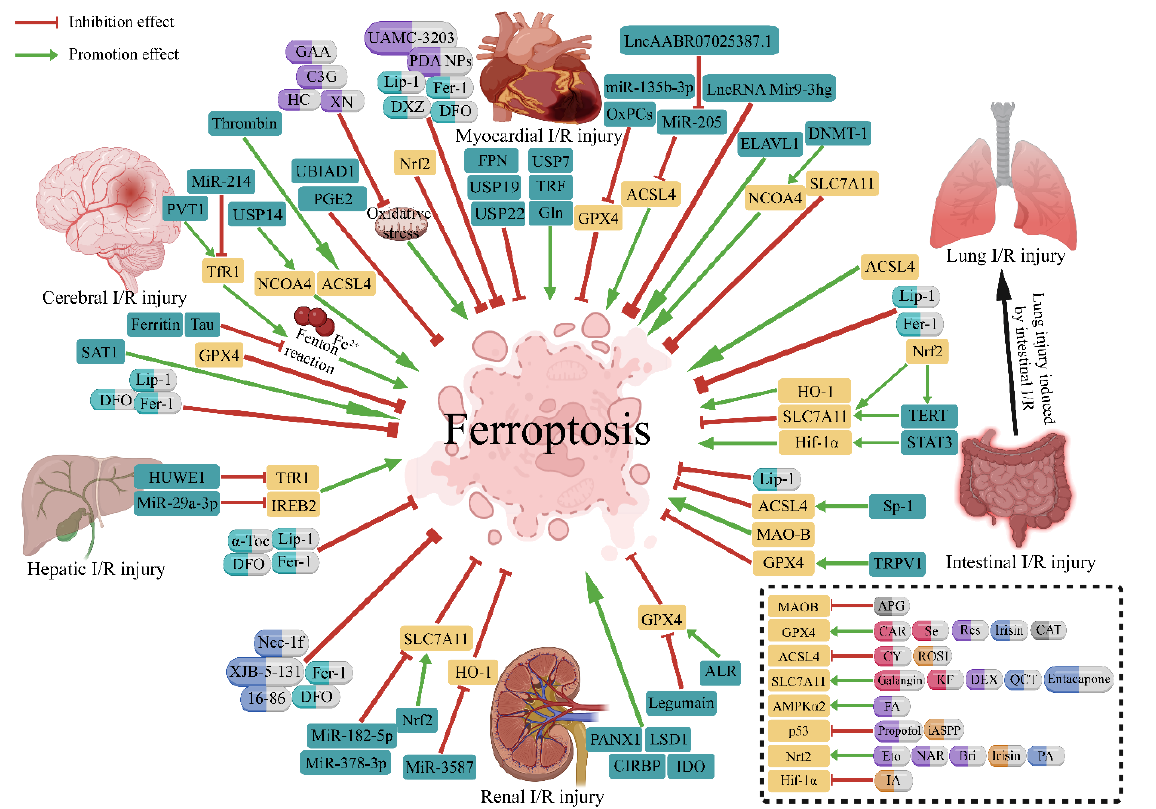
Figure 2. Therapeutic strategies targeting ferroptosis in ischemia-reperfusion injury. Regulatory genes and pharmacological therapies of ferroptosis investigated in I/R injury are summarized in the figure. Green capsules represent well-recognized ferroptosis inhibitors, red capsules represent agents studied in cerebral I/R injury, purple for myocardial, yellow for lung, blue for renal and gray for intestinal. I/R, ischemia-reperfusion; GPX4, glutathione peroxidase 4; ACSL4, acyl-CoA synthetase long-chain family member 4; NCOA4, nuclear receptor coactivator 4; SLC7A11, solute carrier family 7 member 11; Nrf2, nuclear factor erythroid 2-related factor 2; HO-1, heme oxygenase 1; MAO-B, monoamine oxidase b; IREB2, iron response element-binding protein 2; TfR1, transferrin receptor 1; AMPK α 2, adenosine 5 (cid:48) -monophosphate-activated protein kinase α 2; p53, protein 53; FPN, ferroportin; USP7, ubiquitin-specific peptidase 7; USP14, ubiquitin-specific peptidase 14; USP19, ubiquitin-specific peptidase 19; USP22, ubiquitin-specific peptidase 22; TRF, transferrin; Gln, glutamine; MiR, microRNA; OxPCs, oxidized phosphatidylcholines; LncRNA, long non-coding RNA; ELAVL1, embryonic lethal-abnormal vision like protein 1; DNMT-1, DNA (cytosine-5)-methyltransferase 1; Nrf2, nuclear factor erythroid 2-related factor 2; TERT, telomerase reverse transcriptase; STAT3, signal transducer and activator of transcription 3; Sp1, special protein 1; TRPV1, transient receptor potential cation channel subfamily V member 1; LSD1, lysine- specific demethylase 1; Panx1, pannexin 1; CIRBP, cold-inducible RNA-binding protein; IDO, indoleamine 2,3-dioxy-genase 1; ALR, augmenter of liver regeneration; HUWE1, HECT domain-containing ubiquitin E3 ligase; SAT1, spermidine/spermine N1-acetyltransferase 1; PVT1, plasmacytoma variant 1; UBIAD1, UbiA prenyltransferase domain containing 1; PGE2, prostaglandin E2; Fer-1, ferrostatin-1; Lip-1, liproxstatin-1; DFO, deferoxamine; DXZ, dexrazoxane; α -Toc, α -tocopherol; GAA, gossypol acetic acid; C3G, cyanidin-3-glucoside; XN, xanthohumol; HC, histochrome; PDA NPs, polydopamine nanoparticles; APG, apigenin-7-O- β -D-(-6 (cid:48)(cid:48) -p-coumaroyl)-glucopyranoside; CAR, carvacrol; Se, selenium; Res, resveratrol; CAT, capsiate; CY, carthamin yellow; ROSI, rosiglitazone; KF, kaempferol; DEX, dexmedetomidine; QCT, quercetin; FA, ferulic acid; iASPP, inhibitor of apoptosis-stimulating protein of p53; Eto, etomidate; NAR, naringenin; Bri, britanin; PA, pachymic acid; IA, isoliquiritin apioside.